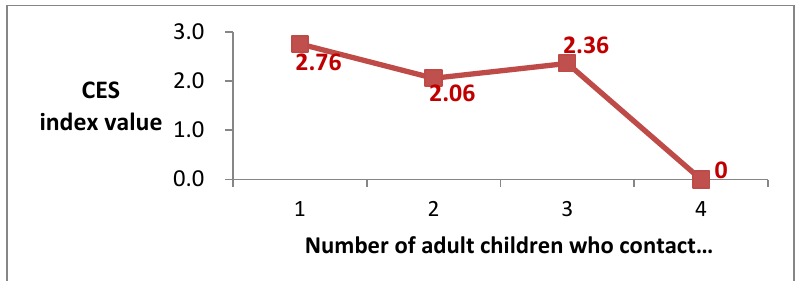
Figure 1. Relationship between CES index values in older adult individuals who care for their grandchildren and contact care provided by adult children. Source: authors’ calculations using Korean Longitudinal Study of Aging data. CES—Center for Epidemiological Studies.